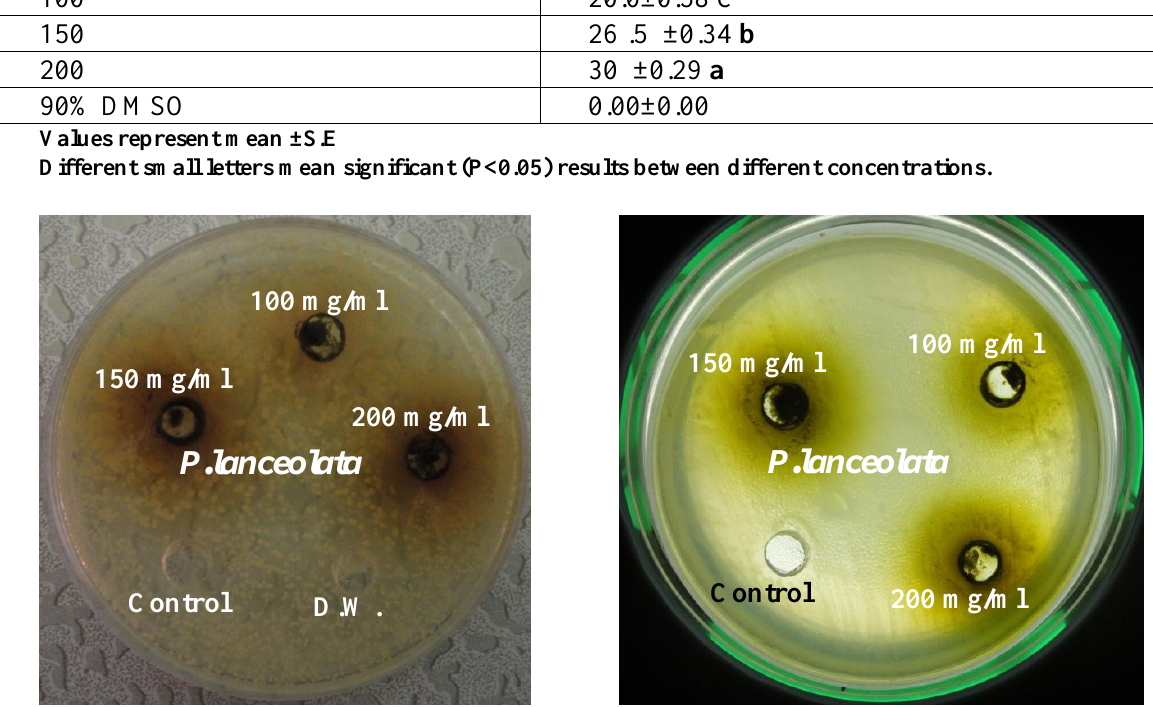
Table (2): In-vitro antibacterial activity of P.lanceolata extract in different concentrations on S.saprophyticus growths (diameter of inhibition zone in mm.) Concentration mg/ml of P. lanceolata L.